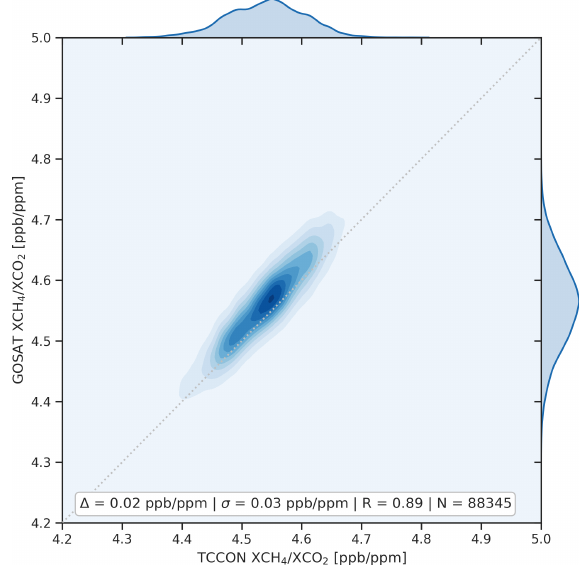
Figure 8. Correlation between the 88345 matching TCCON XCH 4 / XCO 2 ratios and co-located GOSAT XCH 4 / XCO 2 ratios retrieved as a raw fundamental part of the Proxy XCH 4 retrieval (Eq. 1). The data are presented as a two-dimensional kernel density estimation (KDE) plot. The distribution sites along the one-to-one line (grey dashed) with a standard deviation of 0.03ppbppm − 1 and a correlation coefficient ( R ) of 0.89. An overall bias to TCCON of 0.02ppbppm − 1 is present in these raw data. The individual KDE plots are shown along the upper and right